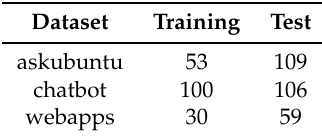
Table 5. Number of utterances in the